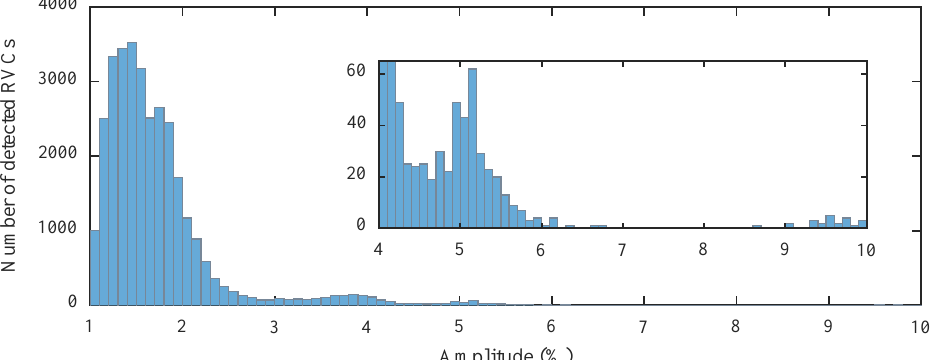
Figure 5. Distribution of the amplitude of the measured RVCs, according to IEC 61000-4-30. The inset shows a zoom of the high amplitude